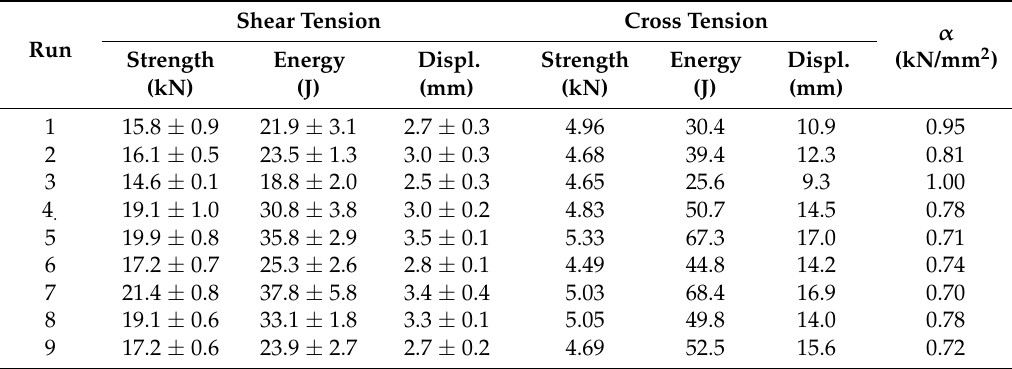
Table 4. Results of the shear and cross tension tests for the different welding configurations. Displ.: displacement; α : cross tension strength normalized to the spot weld